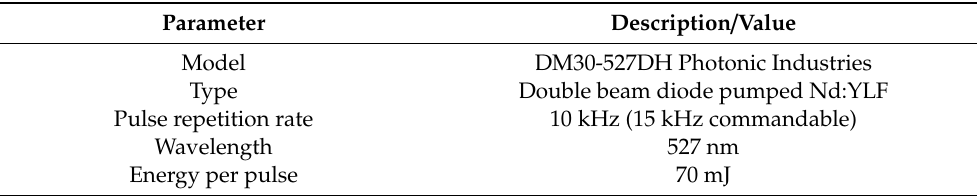
Table 3. Laser parameters.